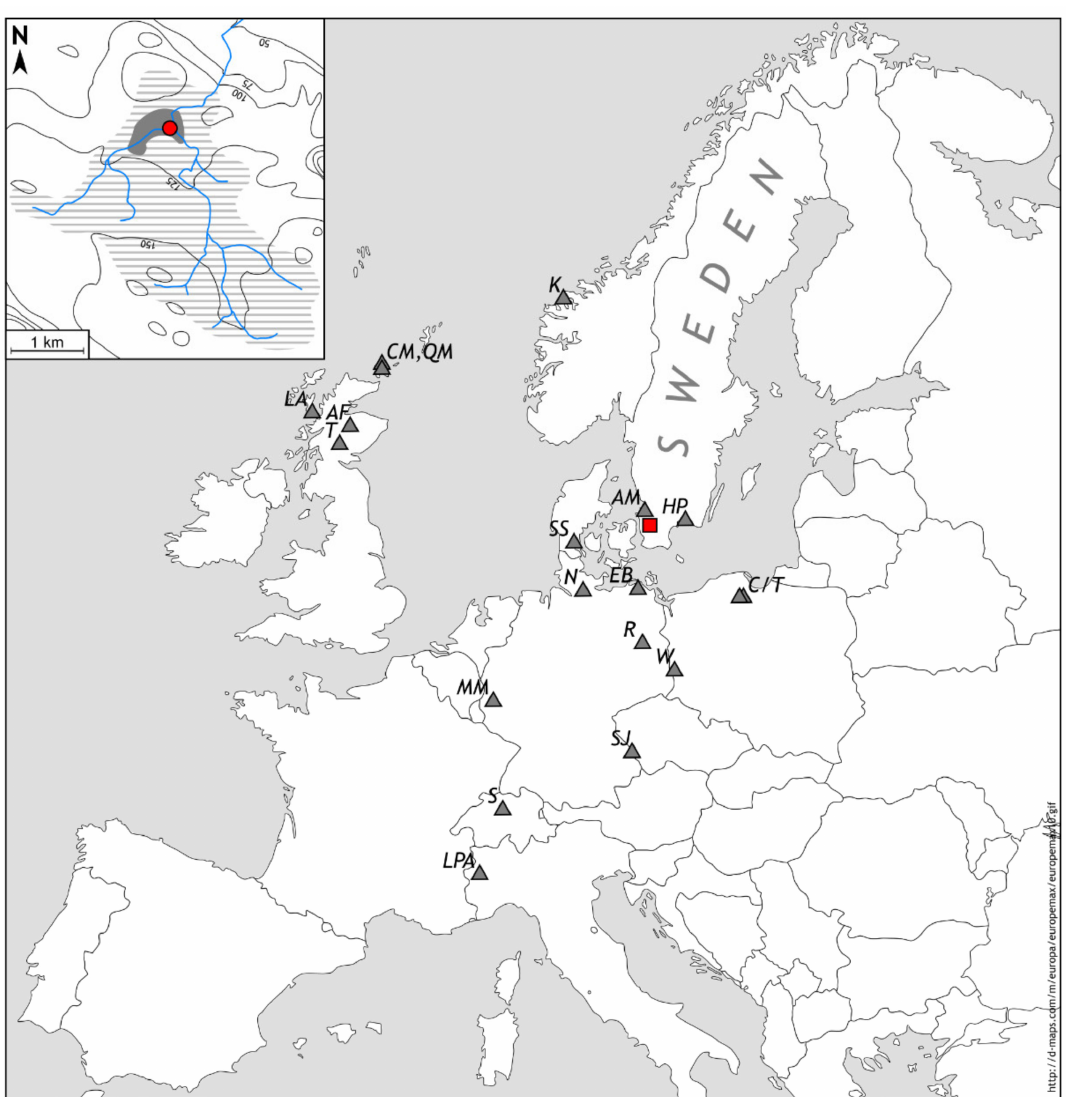
Figure 1. Locations of the study site Körslättamossen in southernmost Sweden (red square) and correlation sites (grey triangles): Abernethy Forest (AF) [59]; Atteköpsmosse (AM) [5,60]; Czechowskie/Trzechowskie (C/T) [31,61,62]; Crudale Meadow (CM) [63–65]; Endinger Bruch (EB) [66]; Hässeldala port (HP) [5,67–69]; Kråkenes (K) [70,71]; Lago Piccolo di Avigliana (LPA) [40,72]; Loch Ashik (LA) [59,73]; Meerfelder Maar (MM) [32,74,75]; Nahe (N) [53,76]; Quoyloo Meadow (QM) [77–79]; Rehwiese (R) [4]; Soppensee (S) [36,40,80–82]; Star á J í mka (SJ) [52,83]; Store Slotseng (SS) [84,85]; Tirinie (T) [6,86]; and Wegliny (W) [87]. Top-left inserted local map shows a simplified topography around the study site: coring location at 56 ◦ 05 (cid:48) 32.8” N 13 ◦ 03 (cid:48) 50.0” E (red circle); fen area (grey field); catchment area (striped field); streams (blue lines); and elevation as metres above sea level (solid lines). European map used for the main image from d-maps.com. Inserted map adapted from the first study of the site [54] based on a terrain map from Geological Survey of Sweden